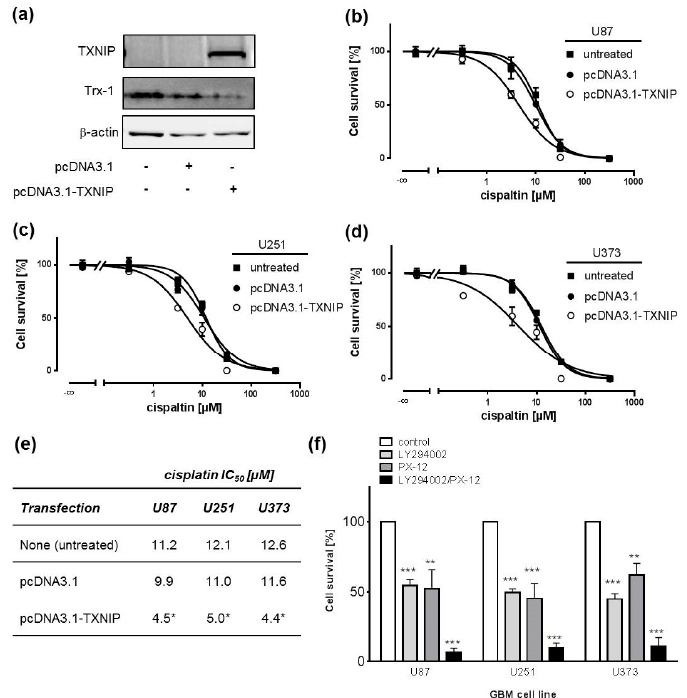
Figure 3. Overexpression of the tumour suppressor TXNIP inhibits Trx expression and sensitizes GBM cell lines to cisplatin. ( a ) Representative Western blots of U87 cells showing overexpression of TXNIP and downregulation of Trx-1 protein expression after transient transfection with